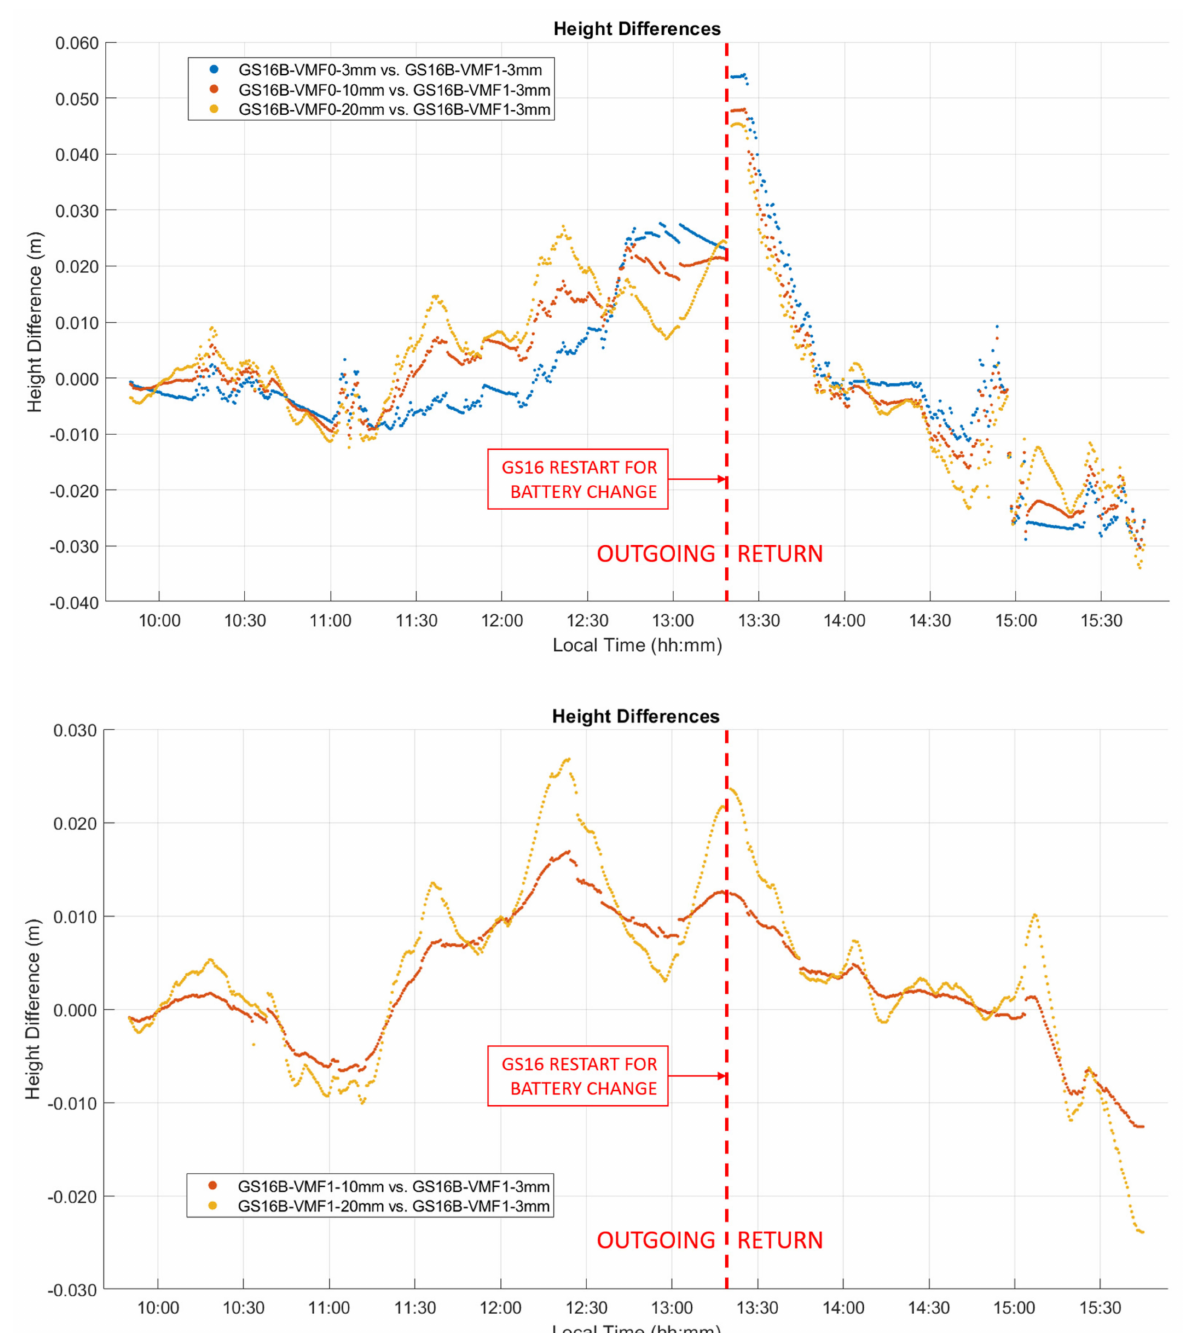
Figure 17. Kinematic dataset B GS16B receiver comparison of PPP height solutions using a constant value of zero as the ZWD a priori input (upper plot) and the VMF1 model as the ZWD a priori input (lower plot), with different levels of process noise. VMF1 model values and PPP solution using VMF1 model as a priori with 3 mm/ both plots. Local time is UTC −